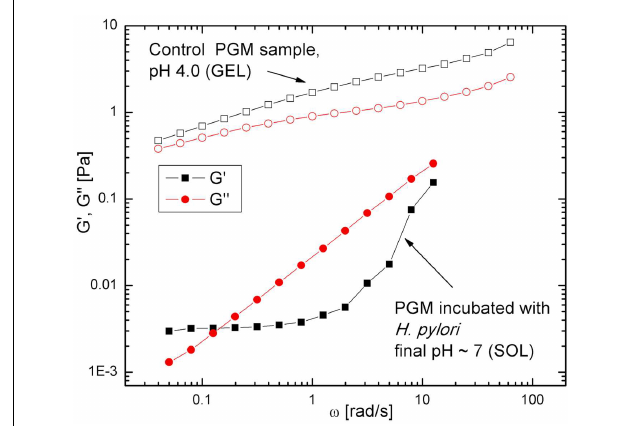
FIGURE 8 | Frequency dependent viscoelastic moduli, for H. pylori infected PGM and control sample, both at pH 4 initially .The elastic response G (cid:48) (open black symbols) and viscous response G (cid:48)(cid:48) (filled red symbols) data show that the control sample is a gel ( G (cid:48) > G (cid:48)(cid:48) ) while the infected sample is a solution ( G (cid:48)(cid:48) > G (cid:48) ). From Celli et al. (31). Copyright permission not required per PNAS policy effective January